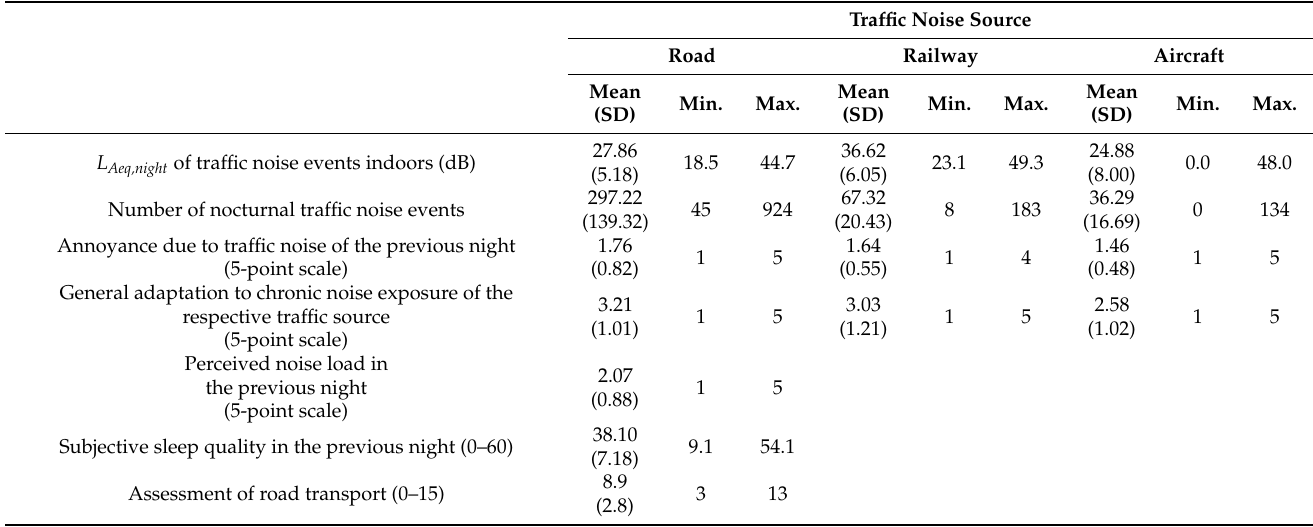
Table 1. Descriptive statistics of short-term annoyance and its acoustical and non-acoustical predictors.